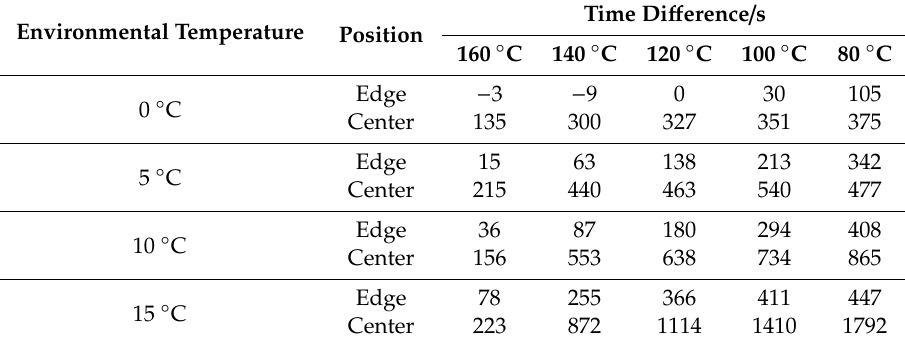
Table 3. Time difference corresponding to five temperatures. Table 3. Time di ff erence corresponding to five